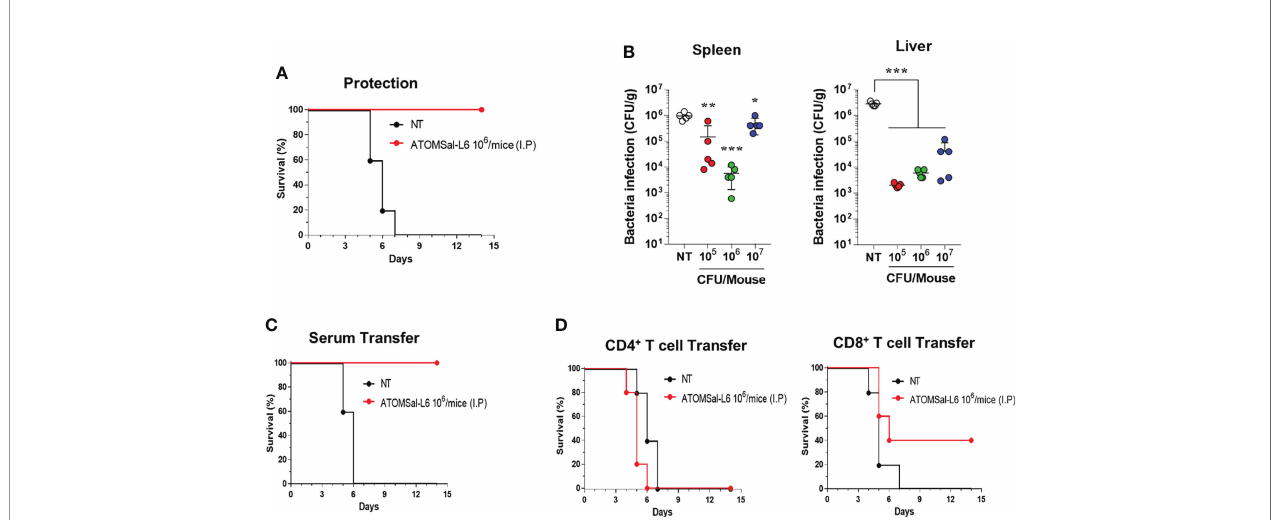
FIGURE 4 | Protective immune responses induced by I.M. immunization of ATOMSal-L6. (A, B) Protective immune response. ATOMSal-L6 immunized mice (n=5) were challenged i.p. with 5 × 10 5 CFU ST WT strain and survival was monitored for 14 days (A) . Protection of Salmonella colonization in mice organs by ATOMSal- L6 vaccination were measured by counting the number of bacteria in the spleen (left panel), and liver (right panel) (B) . Data were presented as mean ± standard deviation. *P < 0.05, **P < 0.01, ***P < 0.001, compared to unvaccinated mice. (C, D) Protection by the adopted transfer of ATOMSal-L6-vaccinated mice serum (C) and CD4 + or CD8 + T cells (D) against Salmonella infection. Mice were immunized with ATOMSal-L6 thrice at 14-day intervals. Serum (100 m L) or splenic CD4 + (5 × 10 6 cells) or CD8 + T cells (5 × 10 5 cells) from NT or ATOMSal-L6-immunized mice were transferred i.p. into naïve C57BL/6 mice (n=5). At 12 h following inoculation, mice were challenged intraperitoneally with 5 × 10 5 CFU ST WT strain. Mouse survival was monitored for 14 with ATOMSal-L6 (10 8 CFU) at two-weeks interval, followed by injecting i.p. ST WT (ST454; 5 × 10 5 CFU). As shown in Figure 5D , all unvaccinated mice died at 14 d.p.i, but 60% of the vaccinated mice survived for more than 14 d.p.i. To examine whether the protective immune response was due to humoral or cellular immune responses, sera (100 m L/mouse), CD4 + T cells (5 × 10 6 cells/mouse), or CD8 + T cells (5 × 10 5 cells/mouse) were collected from ATOMSal-L6 vaccinated or unvaccinated mice, followed by adopted transfer to naïve mice (n=5/group). After infecting with ST WT (5 × 10 5 CFU), all mice transferred with sera or T cells from unvaccinated mice died at 6 - 7 d.p.i whereas 80%, 40%, and 20% of the mice transferred with sera ( Figure 5E ), CD4 + T cells, and CD8 + T cells ( Figure 5F ), respectively. All